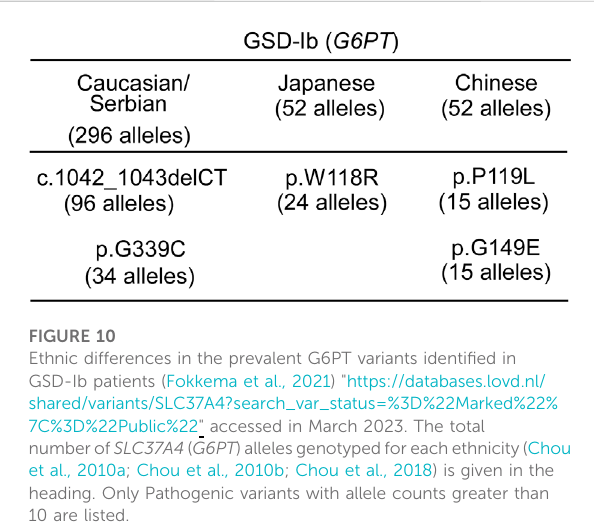
FIGURE 10 Ethnic differences in the prevalent G6PT variants identi fi ed in GSD-Ib patients (Fokkema et al., 2021) "https://databases.lovd.nl/ shared/variants/SLC37A4?search_var_status=%3D%22Marked%22% 7C%3D%22Public%22" accessed in March 2023. The total numberof SLC37A4 ( G6PT )allelesgenotypedforeachethnicity(Chou et al., 2010a; Chou et al., 2010b; Chou et al., 2018) is given in the heading. Only Pathogenic variants with allele counts greater than 10 are